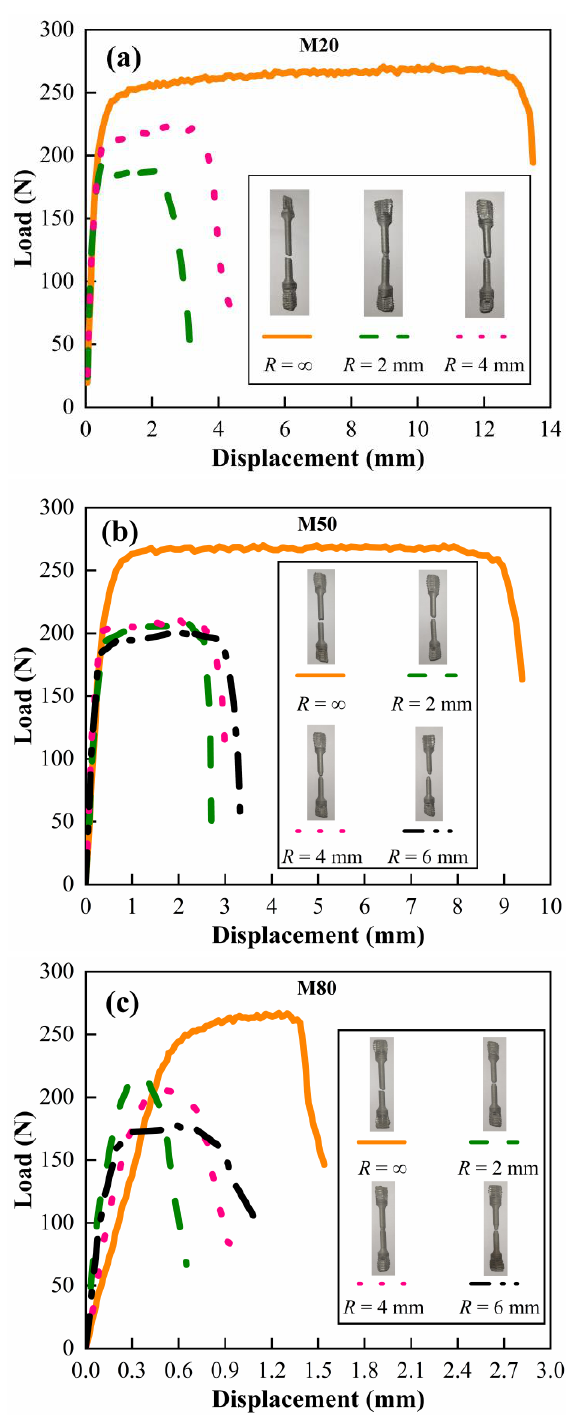
Figure 6. Load–displacement curves in quasi-static tensile tests for ( a ) M20, ( b ) M50 and ( c ) M80.